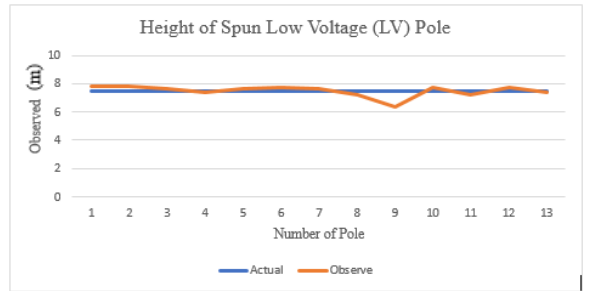
Figure 12 . The Height of Spun Pole Low